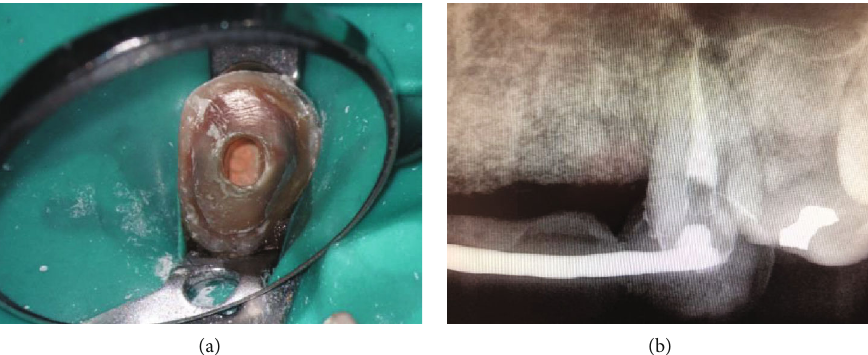
Figure 3: (a) Clinical photograph of the obturated tooth #11 prior to placing a temporary fi lling and the provisional FPD. (b) Postoperative radiograph of the obturated tooth #11 with the provisional FPD cemented.